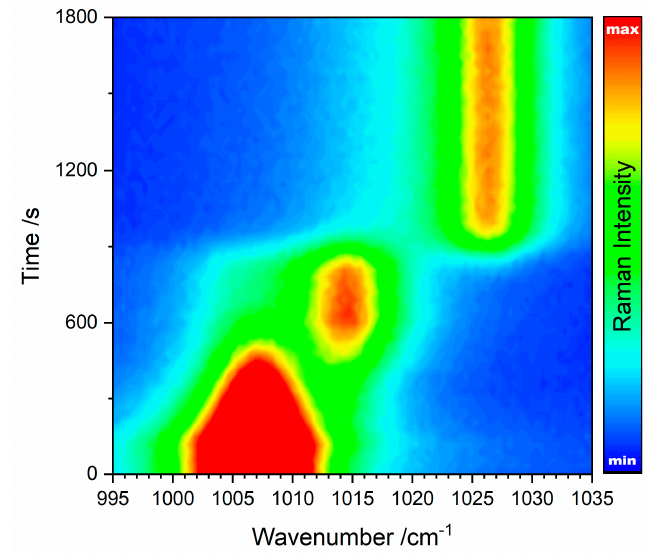
Figure 6. Raman spectra acquired in situ during conversion of 10 mg gypsum powder via bassanite into anhydrite III at T burn = 120 °C.